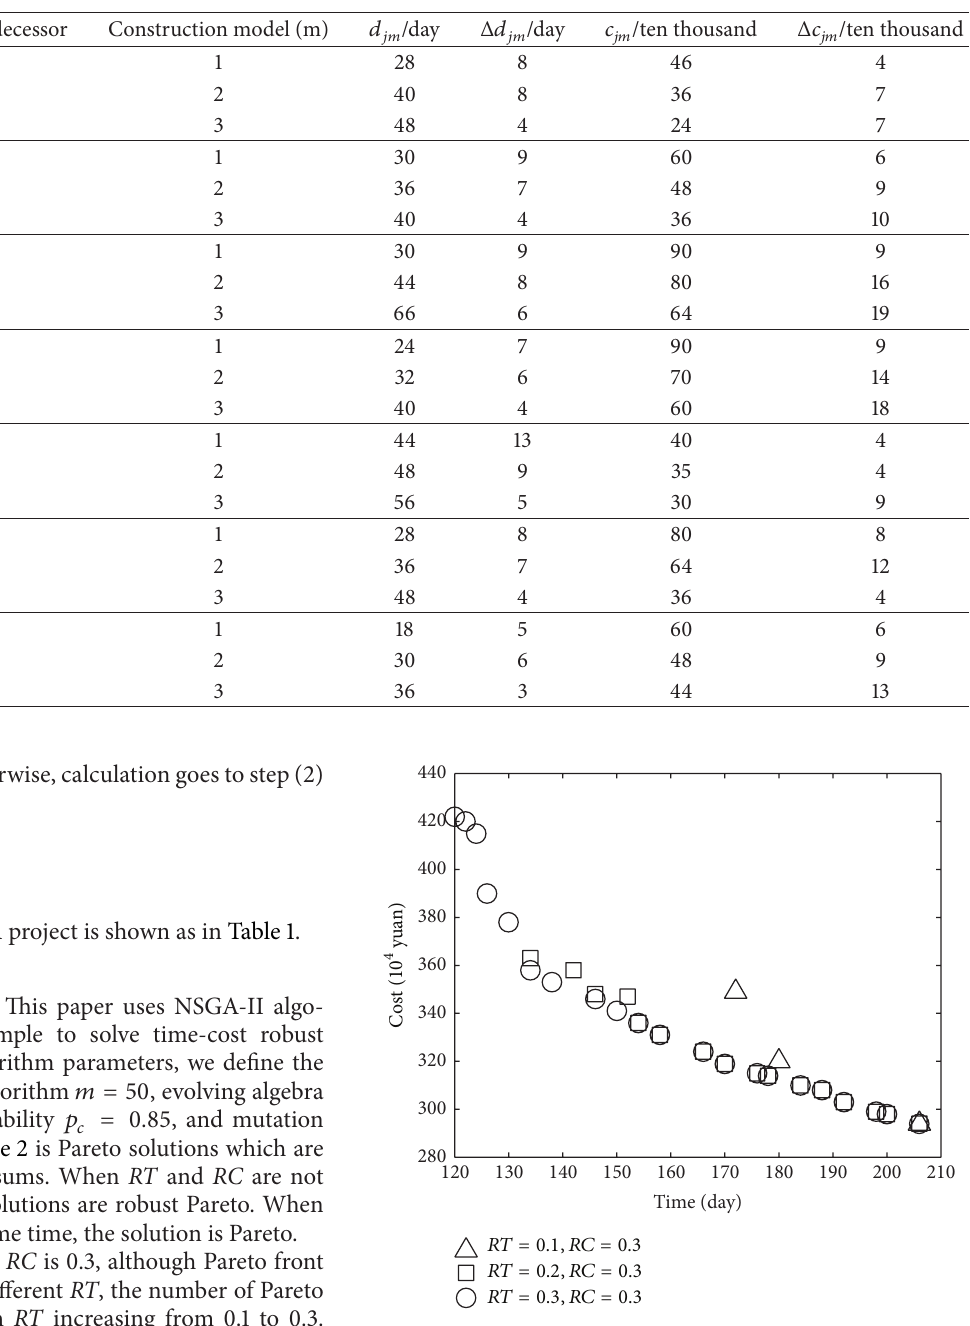
Figure 2: Pareto front porch under different RT